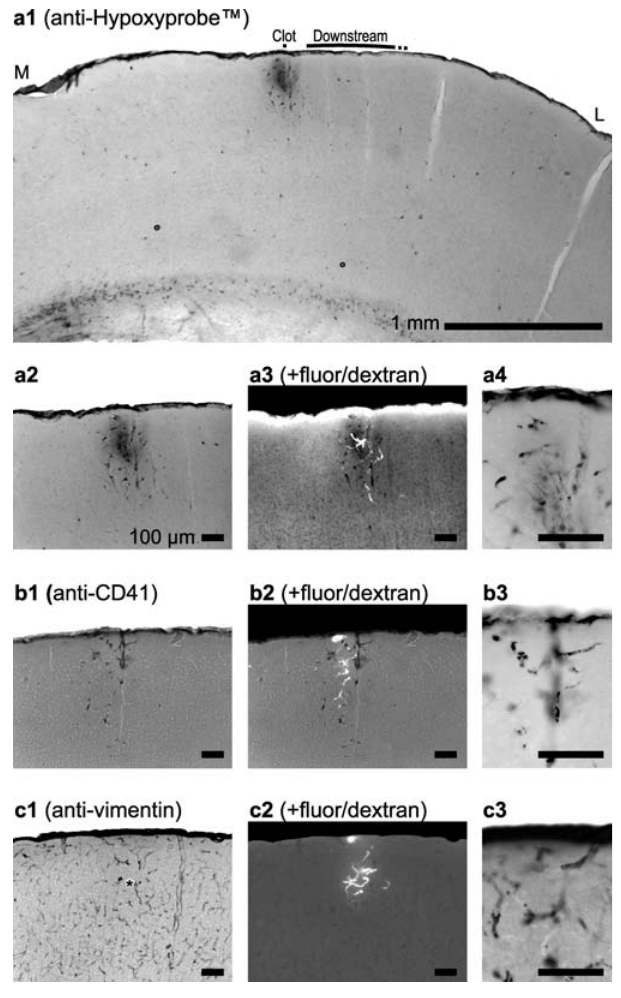
Figure 3. Assay of Oxidative Stress and Vascular